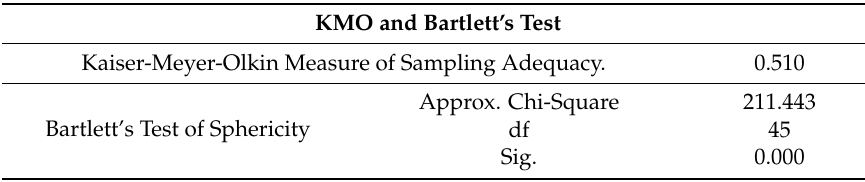
Table 10. Kaiser-Meyer-Olkin (KMO) and Bartlett’s test.